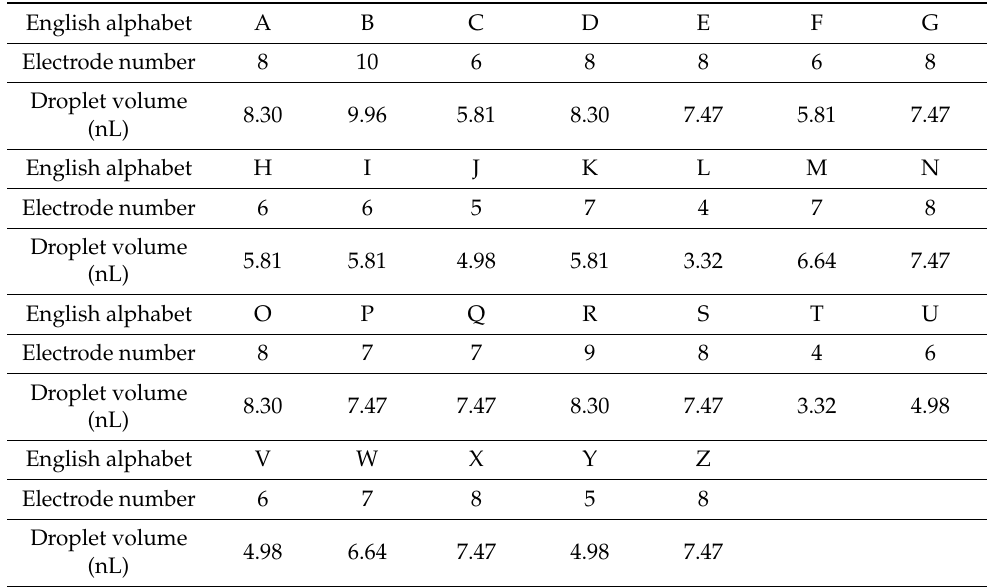
Table 1. Quantity of opening electrodes and droplet volume to pattern an English